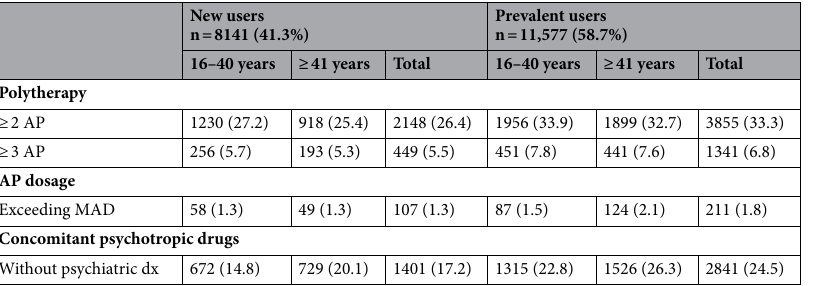
Table 3 shows patterns of pharmacotherapeutic management in schizophrenic patients. The vast majority of patients in monotherapy were treated with an SGA. Both new and prevalent users under treatment with two